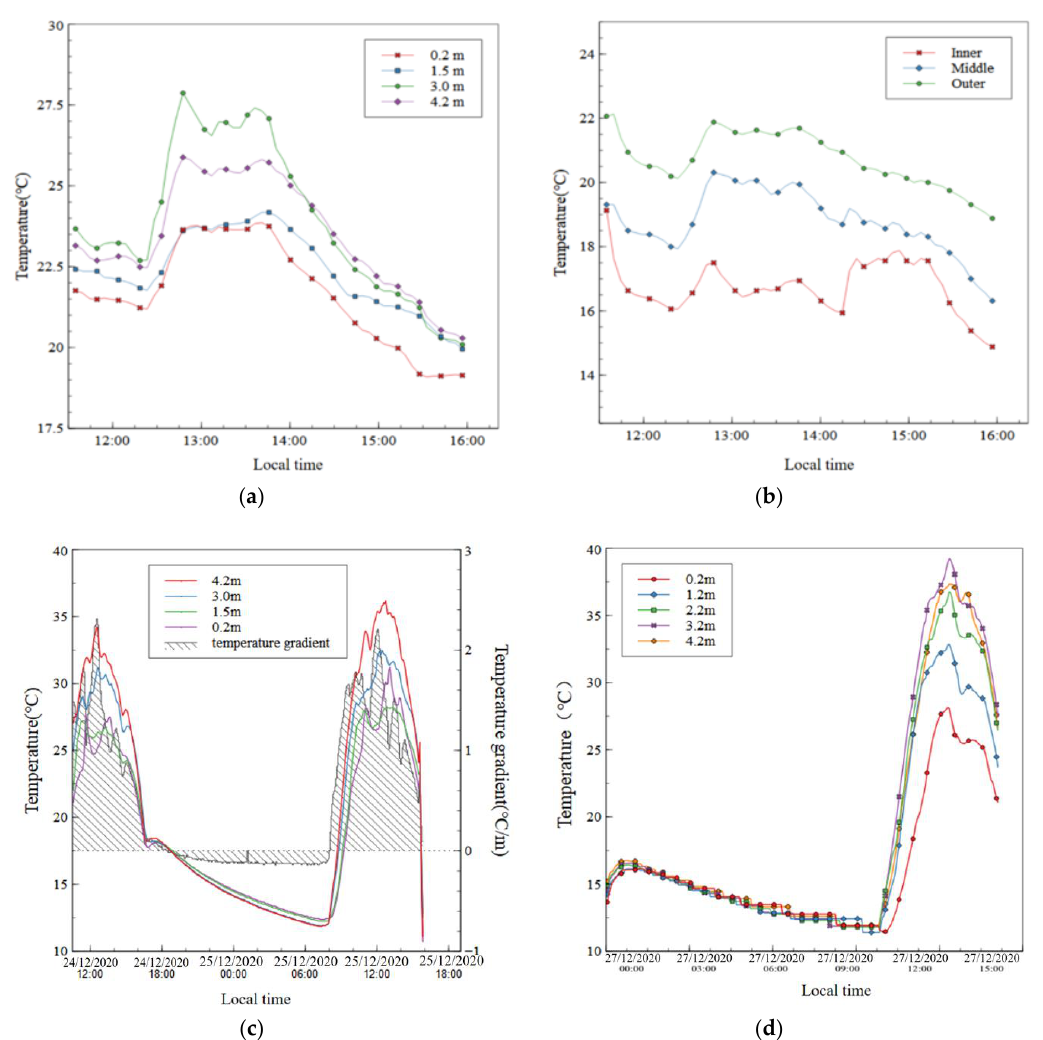
Figure 8. Temperature data of sensors from different heights. ( a ) Sensor data of G3; ( b ) Sensor data of G4; ( c ) Sensor data of G6; ( d ) Sensor data of G8. Table 5. The maximum temperature difference (between max and min of sensor reading) in each greenhouse at the same time.